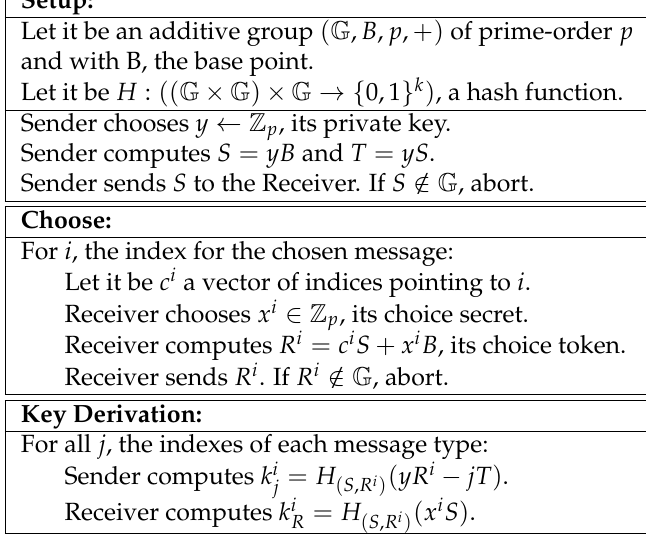
Figure 6. Chou& Orlandi OT 1 n protocol